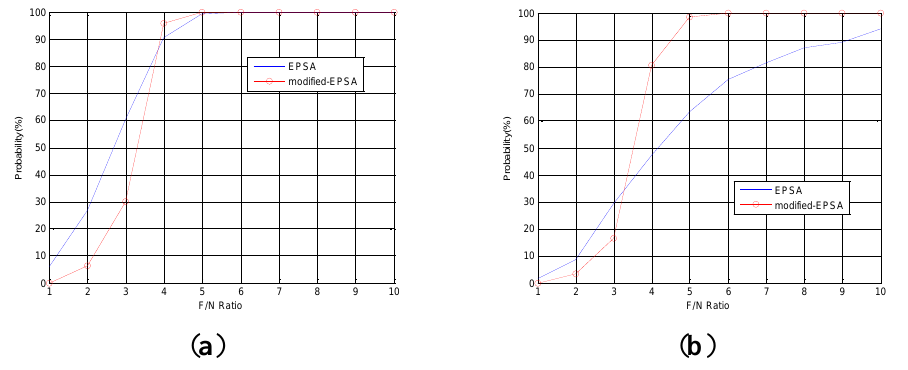
Figure 11. (CASE1) Double faults detection and isolation performance of sensor 1. ( a ) Detection probability. ( b ) Isolation probability.